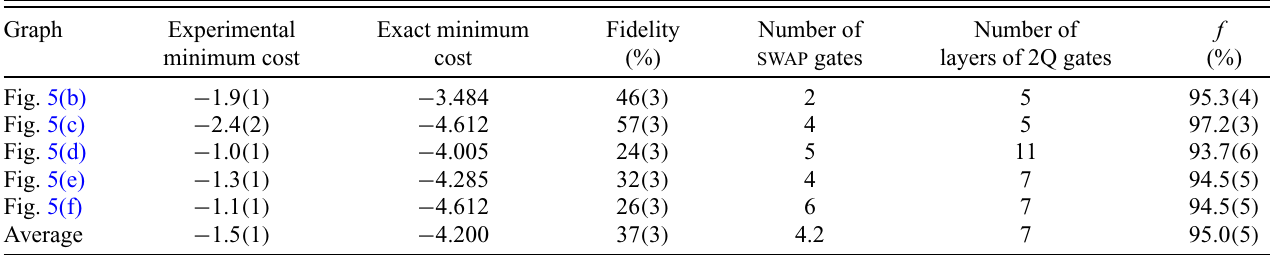
TABLE I. The relevant numerical data for the five unit-weight 3-regular graphs with N = 8 vertices that exist. The fidelity is com- puted with respect to the average exact minimum cost. The individual fidelity f is computed from the global fidelity assuming a number of operations equal to the number of two-qubit gates applied in the circuit. This number equals 12 (the number of edges in a 3-regular graph with N = 8 vertices) plus twice the number of SWAP gates according to Eqs. (A2) and (A1). Graph Experimental